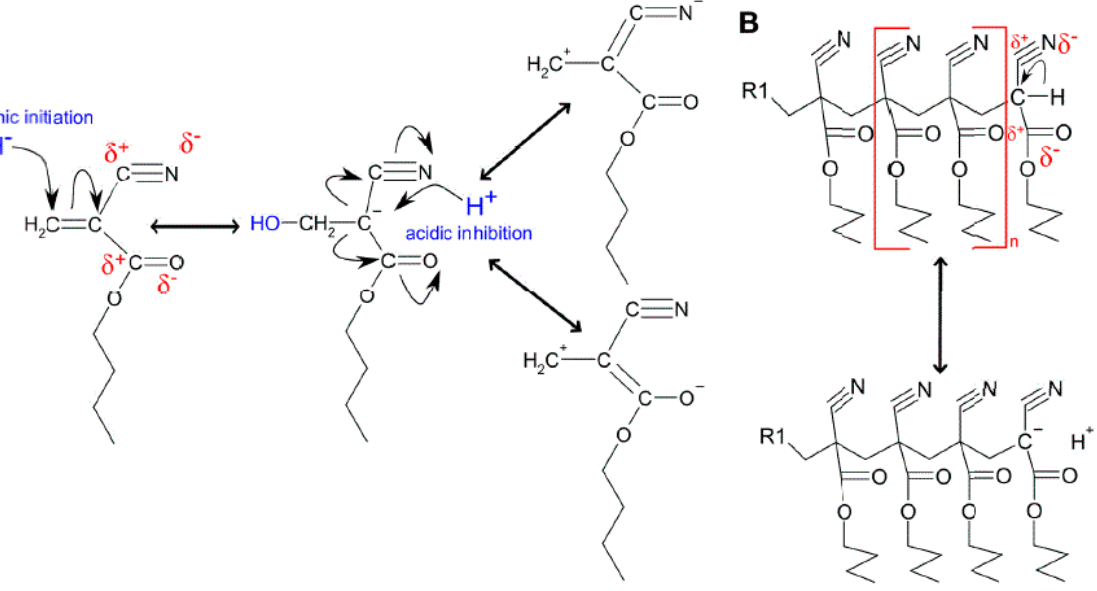
Figure 1. ( A ) Chemical structure of BCA, including possible resonance structures; ( B ) Chemical structures of PBCA and the origin of the C-H acidity appearing on the chain terminus of the polymer. The overall aim of this work was to control and optimize the anionic polymerization process for PBCA to allow tailoring of the polymer MW. Keeping in mind that PBCA can potentially be applied as a pharmaceutical excipient for drug delivery, we further investigated the MW effect on the chemical stability of PBCA and end-capped